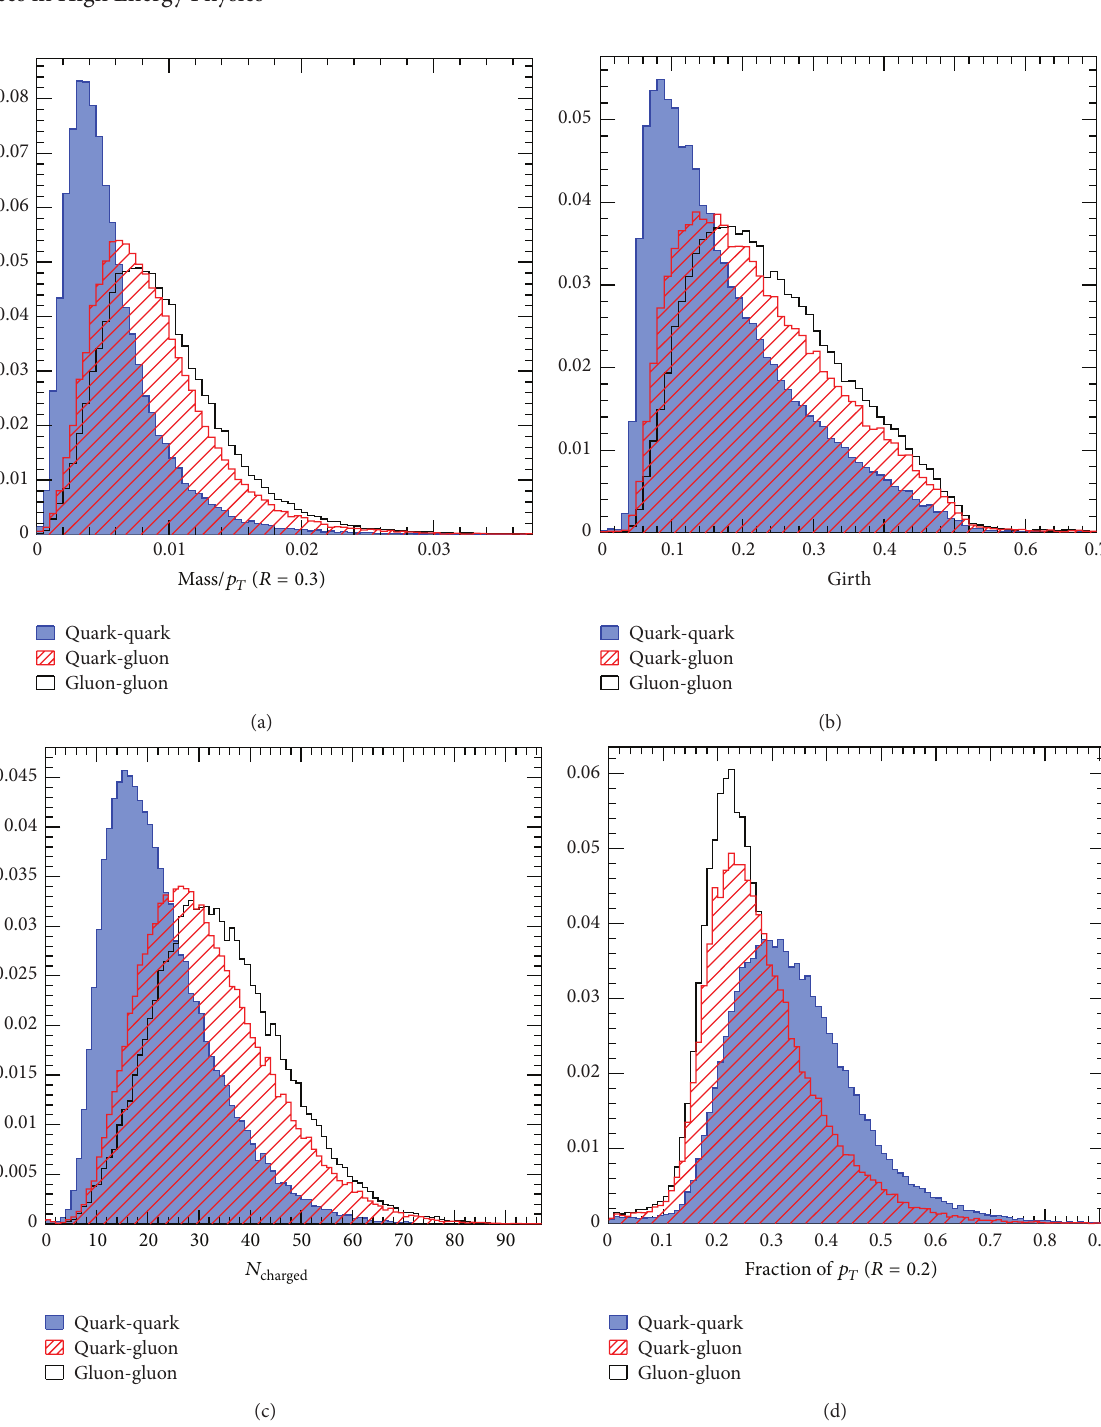
dijet distribution can be considered. Figure 3 shows that 90% of events, which are produced in quark-gluon and gluon- gluon parton pairs, can be rejected in the inclusive QCD dijet mass distribution while keeping around 60% of quark-quark parton pair events.